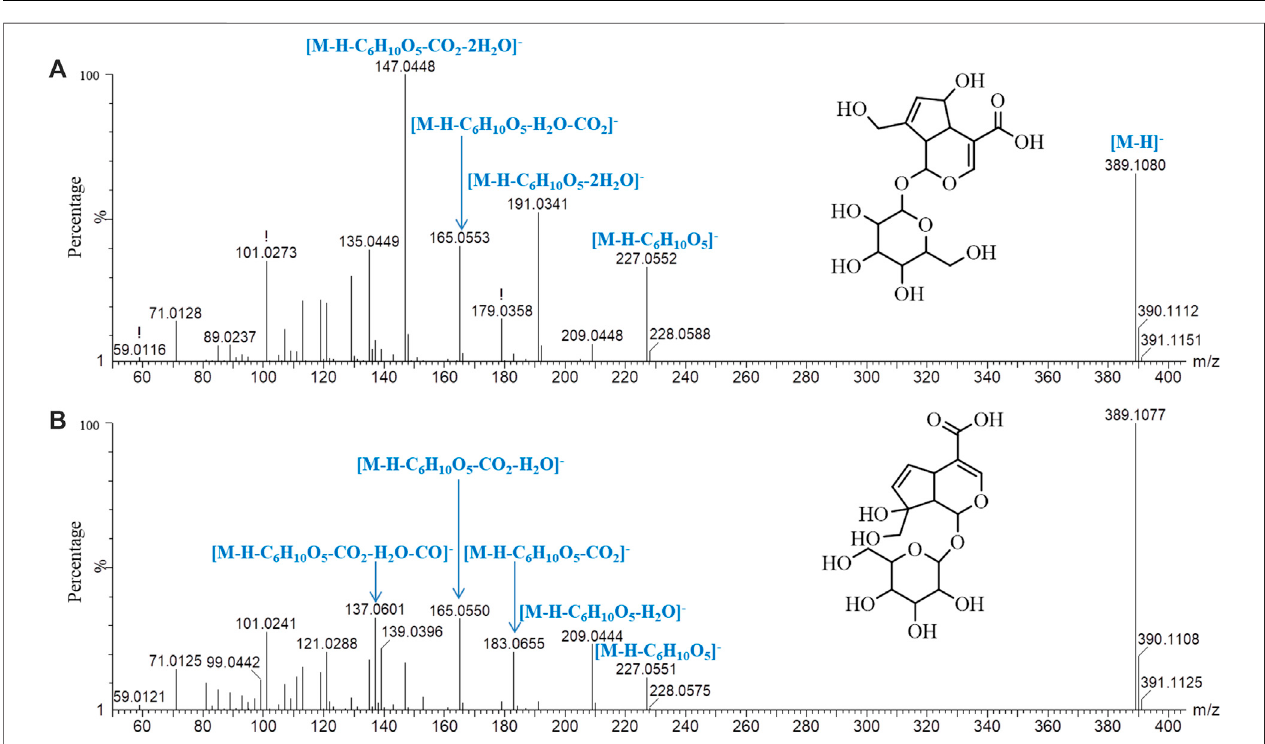
FIGURE 5 | Mass spectrograms and major cleavage pathways of monotropein (A) and DDA (B) at high energy in negative ion mode.